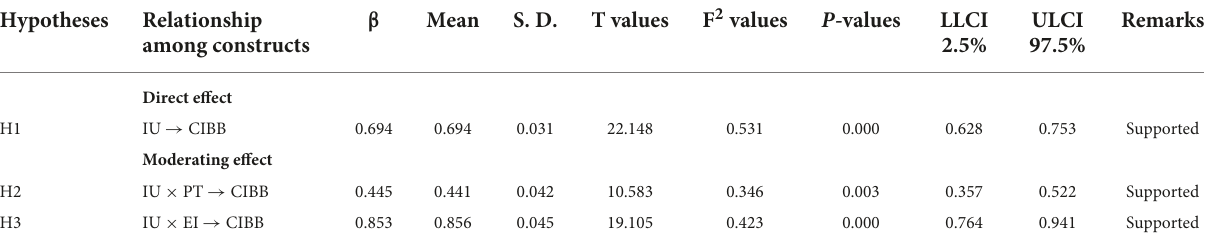
TABLE 3 Structural equations model